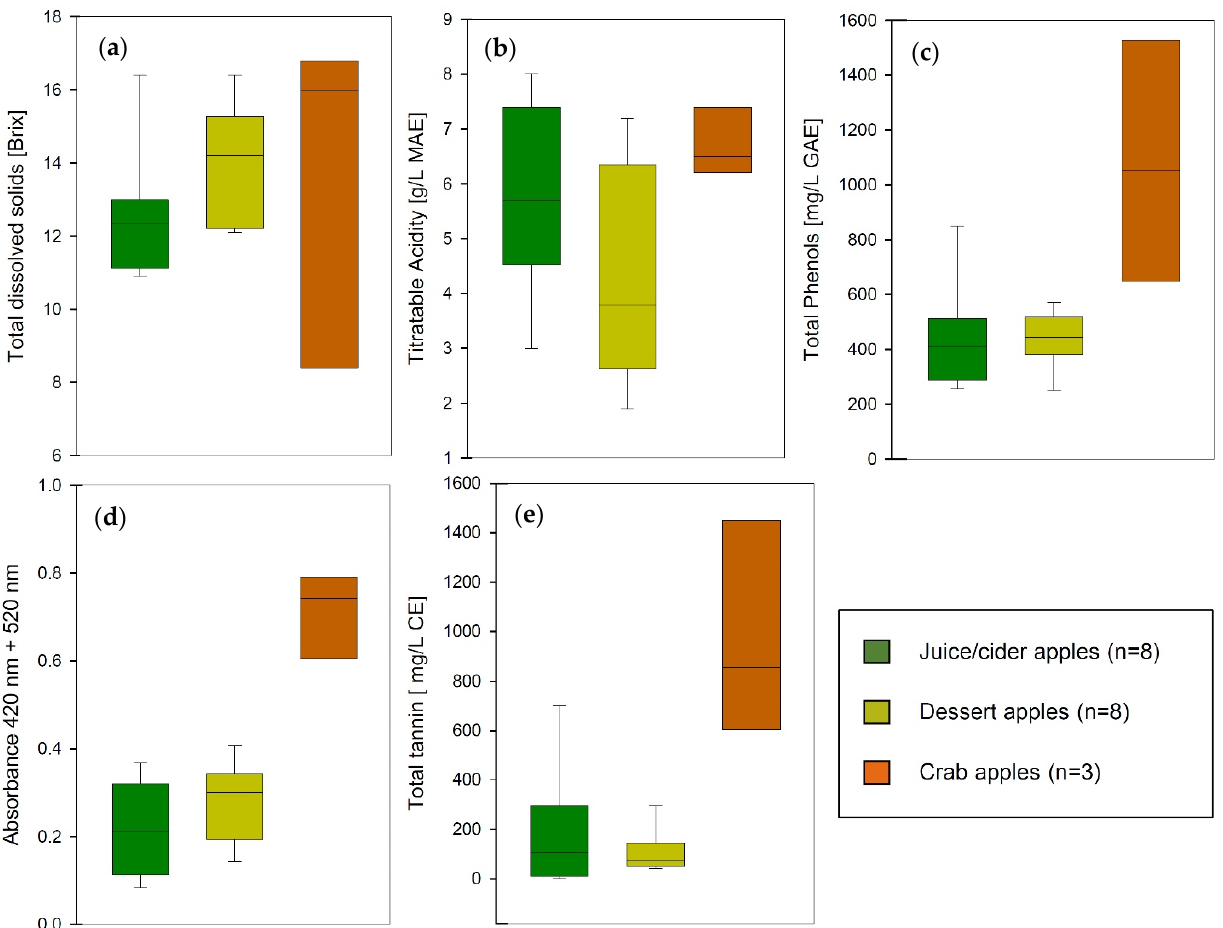
Figure 6. Analytical data of apple varieties sorted by classification as dessert apple, juice or cider apple, and crab apple (MAE: malic acid equivalents; GAE: gallic acid equivalents; CE: catechin equivalents). ( a ) total dissolved solids, ( b ) titratable acidity, ( c ) total polyphenols, ( d ) total color, ( e ) total tannins.